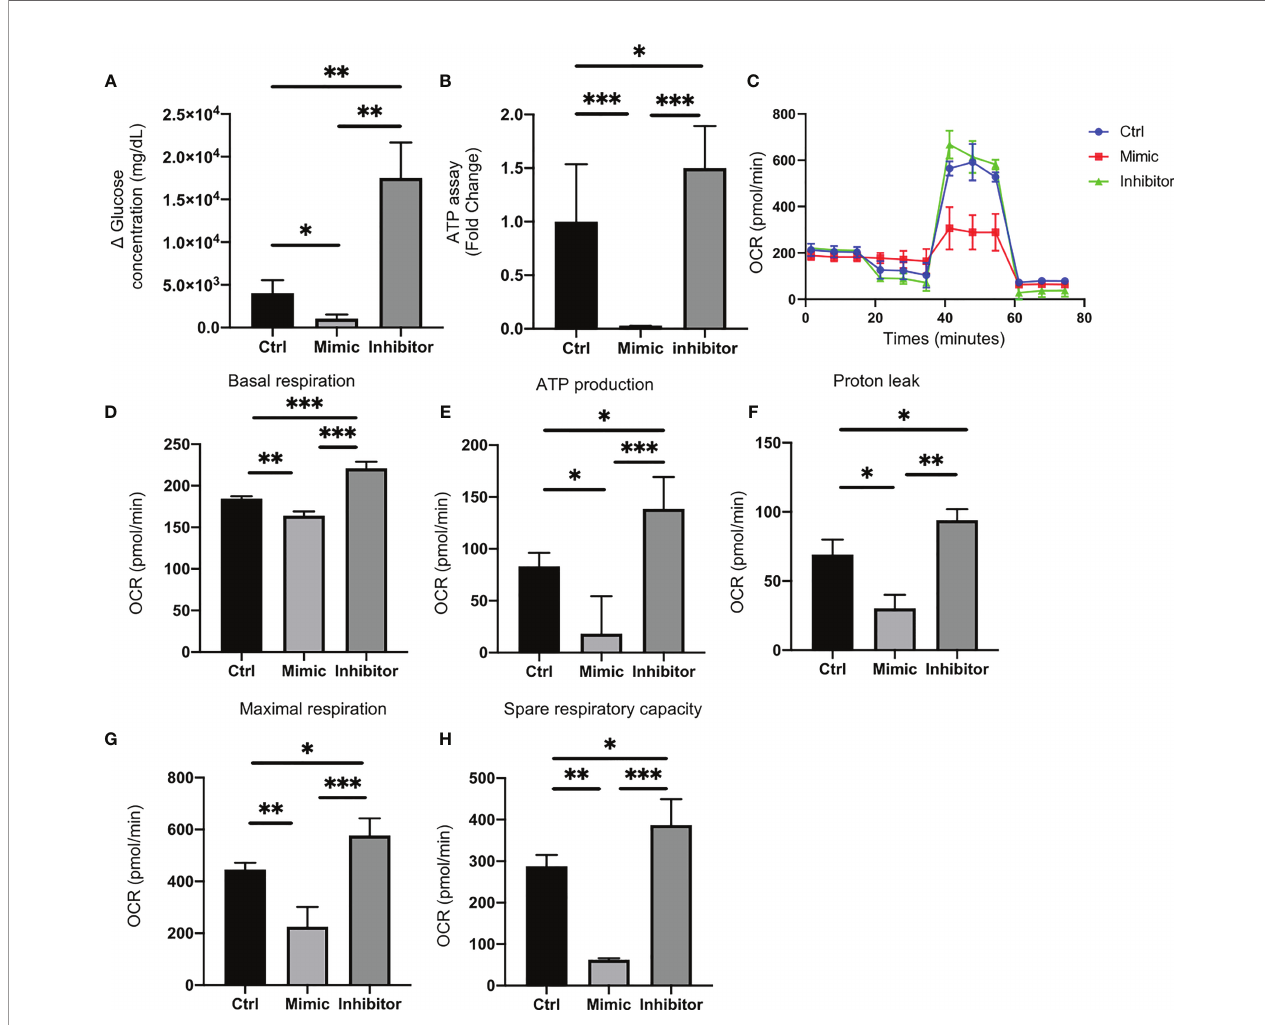
FIGURE 3 | Let-7e-5p decreases glucose uptake and downregulates mitochondrial function in C2C12 cells. (A) Glucose uptake by C2C12 cells was monitored after transfection with let-7e-5p mimic/inhibitor. Glucose uptake was downregulated by let-7e-5p mimicking substrate and upregulated by let-7e-5p inhibitor, compared to negative control (n = 6). (B) ATP assay following transfection with let-7e-5p mimic/inhibitor. ATP production was downregulated by let-7e-5p mimicking substrate and upregulated by let-7e-5p inhibitor, compared to negative control (n = 6). (C) Raw data of oxygen consumption rate (OCR), (D) basal respiration, (E) ATP-linked respiration (oligomycin-sensitive OCR), (F) proton leak, (G) maximal mitochondrial respiration (FCCP-stimulated OCR), and (H) spare respiratory capacity. OCRs were normalized to the total number of cells. Data represent the means±SD; *p = 0.05, **p = 0.01, ***p = 0.001 by one-way